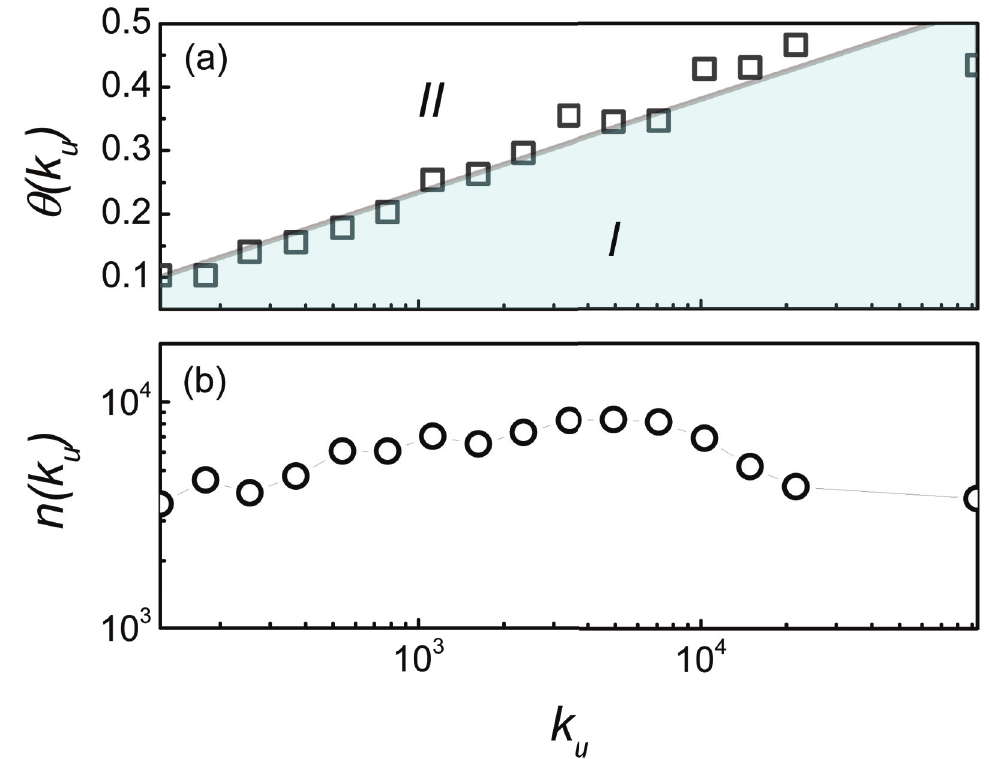
Fig 6. The correlation between the user degree and the taste similarity θ when the relations are created. The users are separated into 16 groups in lg k max u terms of their degrees k u . The step size of the degree within each group is set as d ¼ 1 , then the degree interval of the n th group is [10 n 0 + nd ,10 n 0 +( n +1) d ], 16 k min u where n 0 = 2 and n 2 {0, 1, (cid:2)(cid:2)(cid:2) , 15}. And only the average taste similarity θ at the relation creation time is considered for each group. (a) The joint impact of the taste similarity θ and the user degree k u on trust formation. At the creation time of trust relations, the taste similarity θ continues to increase as the user degree k u increases. And the correlation between the taste similarity θ and the user degree k u is well fi tted by a straight line. Thus the users relation status can be regarded as two status, that is, the unstable status in which the users ’ taste similarity are not reach the value corresponding to the degree (area I), and the trust status in which the trust relation is created between a pair of users since their taste similarity exceeds the corresponding value (area II). (b) The number of relations counted for each